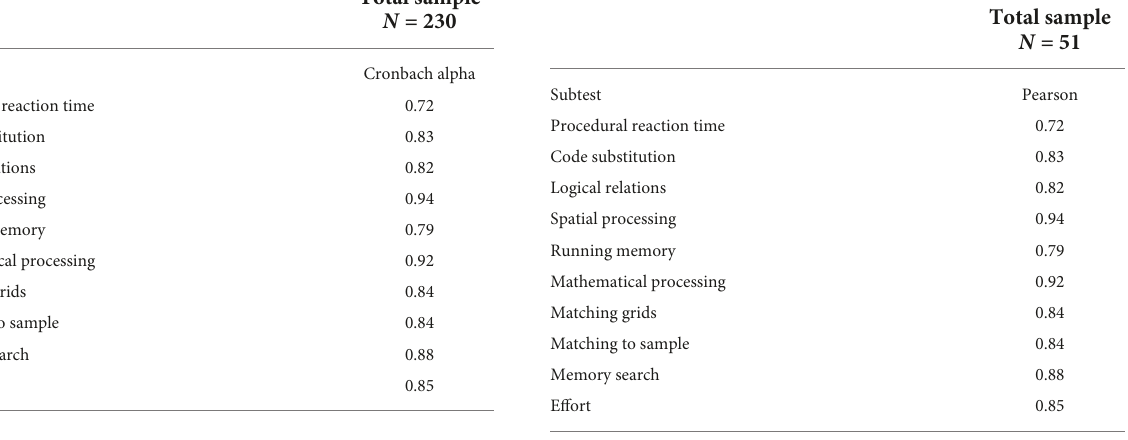
TABLE 6 Ped-ANAM battery internal consistency (Alpha Cronbach).